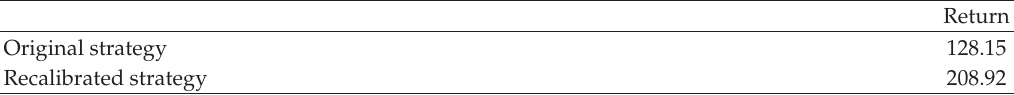
Table 3: Return values for original and recalibrated strategies (cid:6) actual S&P 500 Index path for 2005–2010 (cid:7) .